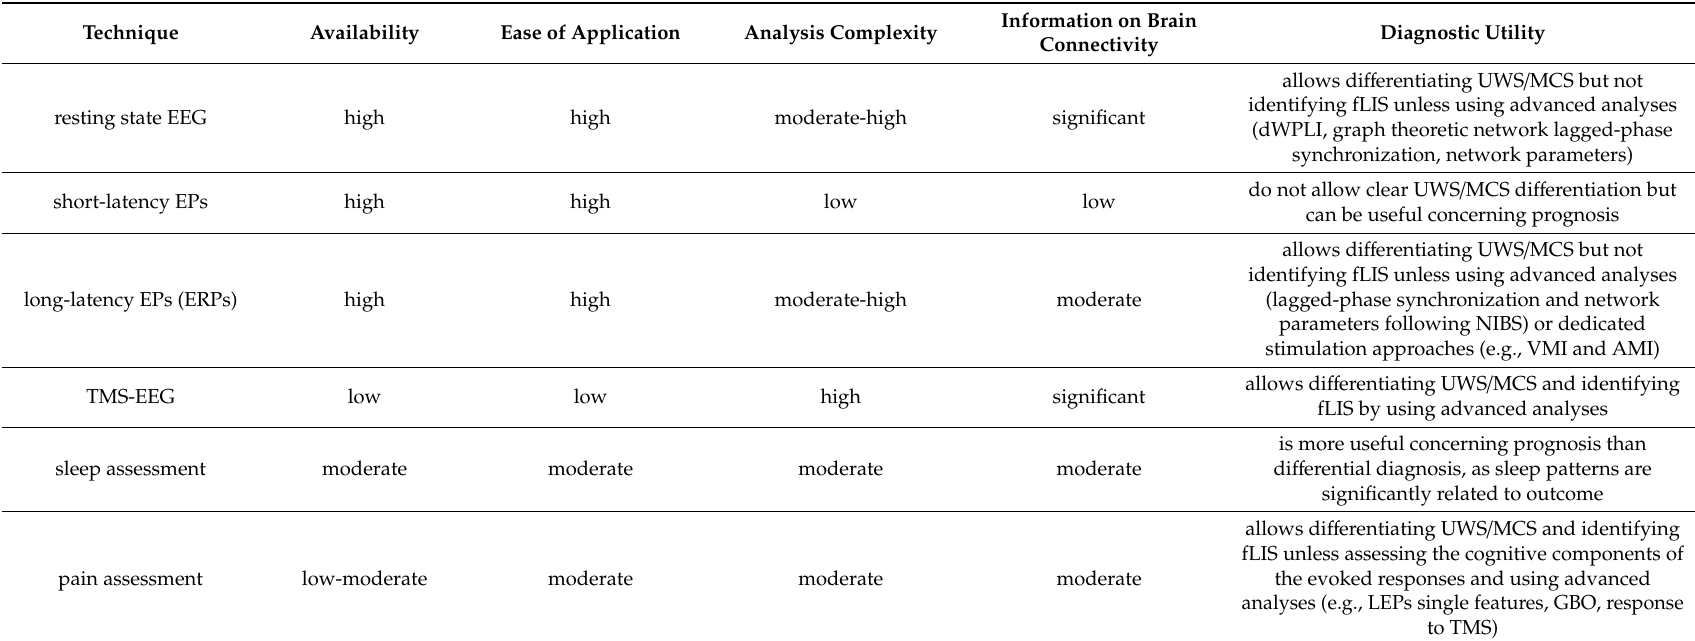
Table 1. Survey of the di ff erent neurophysiological techniques of stimulation to investigate brain function in UWS and